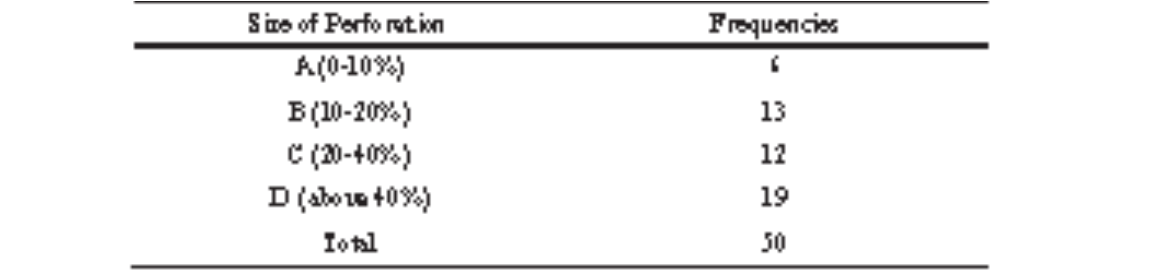
Table III : Size of perforation